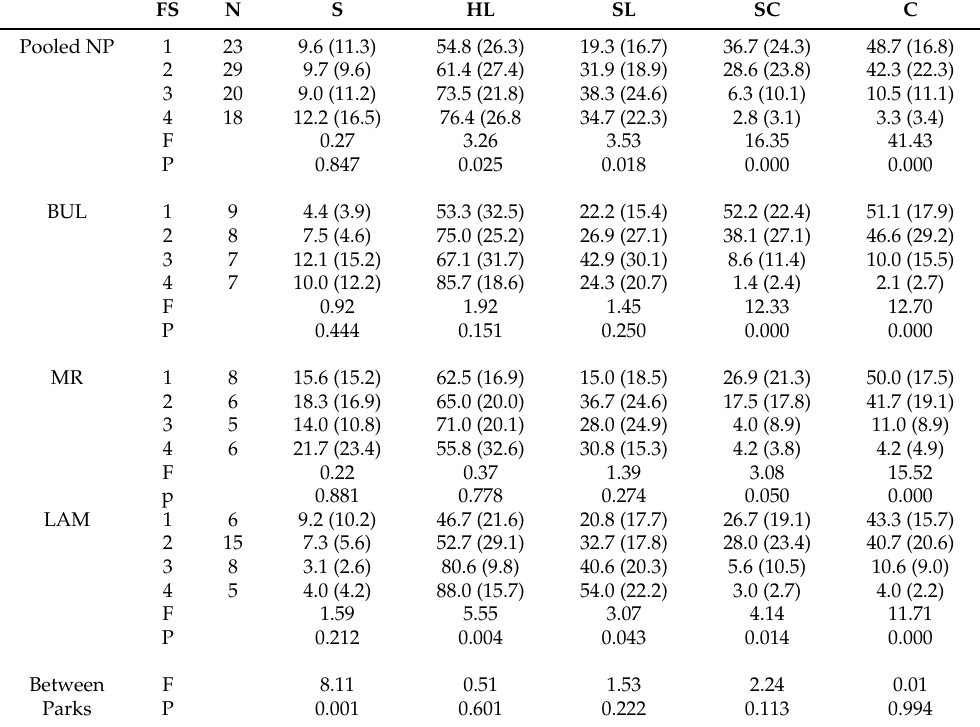
Table 1. Summary table of the mean % cover of each stratum layer against each fire-severity (FS) category (1–4) for pooled National Park (NP) data and individual park assessment (BUL = Bulburin NP, MR = Main Range NP and LAM = Lamington NP). Where substrate (S); herb layer (<1 m) (HL); shrub layer (>1–5 m (SL); sub-canopy (5–10 m) (SC); (canopy (>10 m) (C). Mean values are shown with standard deviation in brackets. The ANOVA F test statistic and p values indicate if there were significant differences among stratum, as well as among the three National Parks.